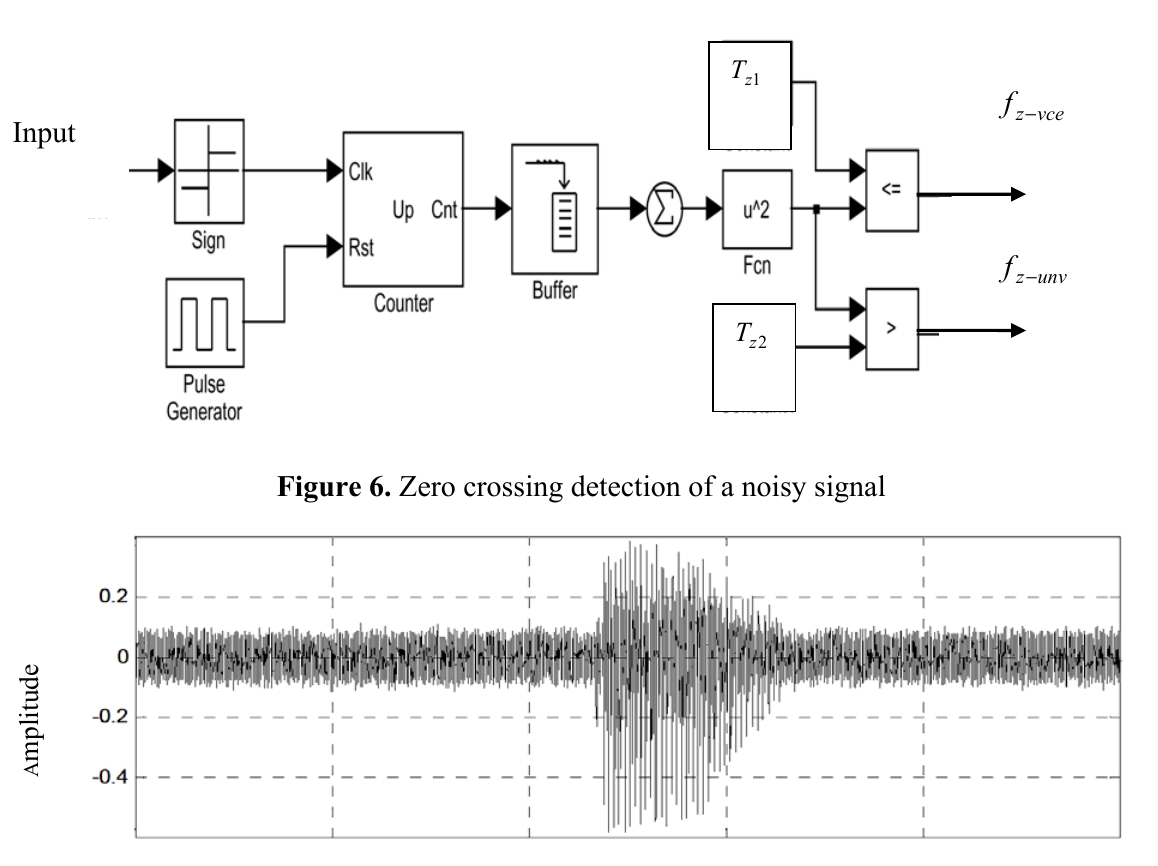
Figure 5. Zero crossing rate calculation.